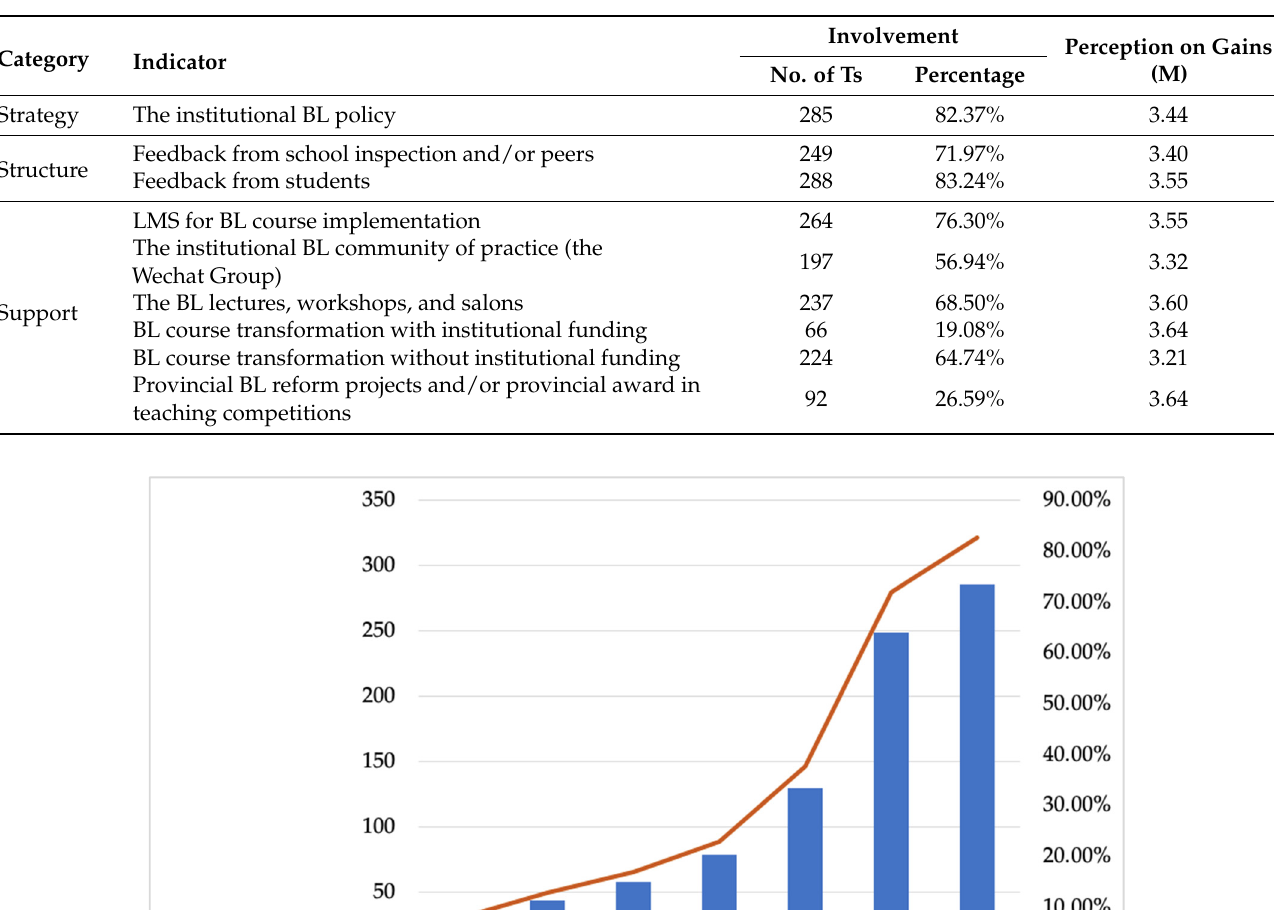
Table 7. S university’s publication of journal papers on BL.